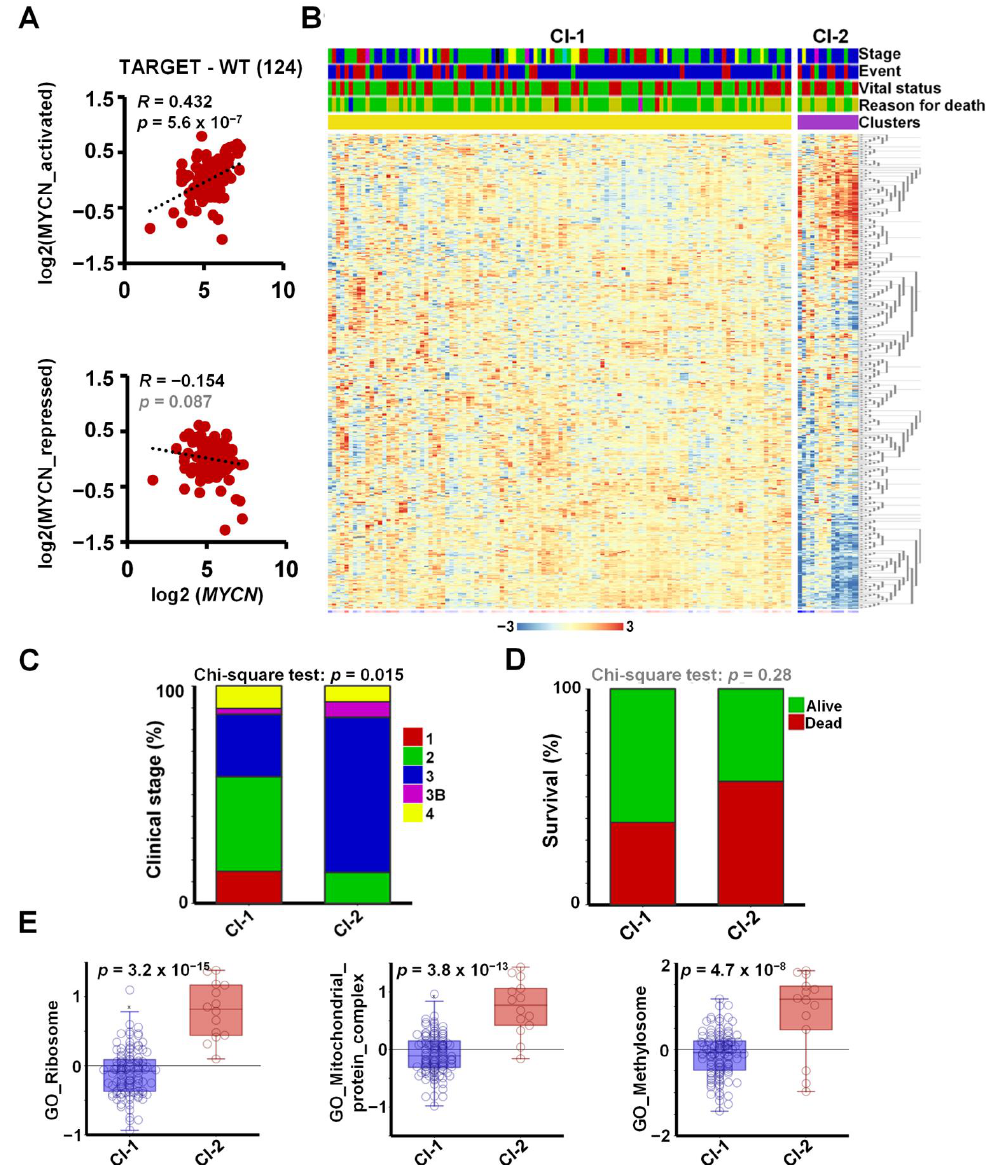
Figure 4. Meta-analysis of MYCN-regulated genes in the WT-TARGET dataset identifies distinct patient clusters. ( A ) Overall expression of MYCN-activated genes, identified as shared downregulated hits in MYCN-depleted WT cells, showed a strong and significant positive correlation with MYCN expression in the TARGET-WT dataset (SRP012006), containing transcriptomic data of 124 high-risk WTs. Overall expression of MYCN-repressed genes displayed a modest inverse correlation that did not reach significance. ( B ) K-means clustering ( K = 2) performed on the TARGET-WT dataset based on the expression of 561 MYCN-regulated genes in WT, identified in this study. Clinical information is shown as coloured bars on the top: stage (red = 1, green = 2, blue = 3, magenta = 3b, yellow = 4, black = 5_3B, turquoise = 5_4), event type (none = red, blue = relapse, green = progression), vital status (green = alive, red = dead) and reason for death (green = none, yellow = tumour, red = infection, blue = toxicity, magenta = tumour and toxicity). ( C ) Proportion of tumours with various clinical stages. Chi-square tests showed that the association of clinical stages with clustering according to MYCN-regulated genes was significant. Stages represented by a single tumour were omitted. ( D ) More death occurred in patients with tumours in Cluster 2; however, this association did not reach significance. ( E ) Overall expression of genes encoding for the ribosome, mitochondrial protein complexes and methylosome components was significantly higher in Cluster 2 tumours as compared with those in Cluster 1